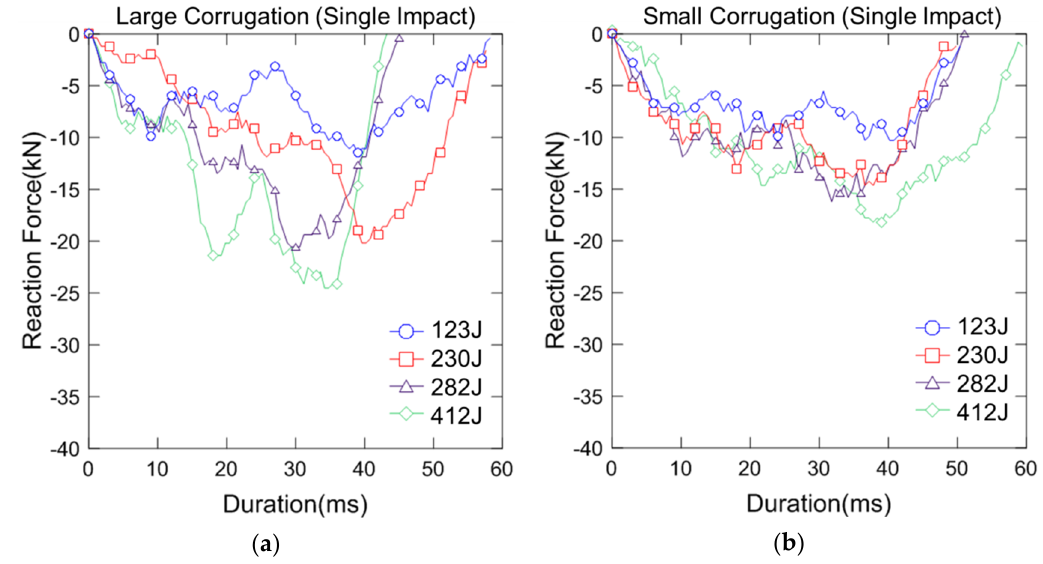
Figure 4. Reaction force profile of ( a ) large and ( b ) small corrugation in accordance with impact energy.